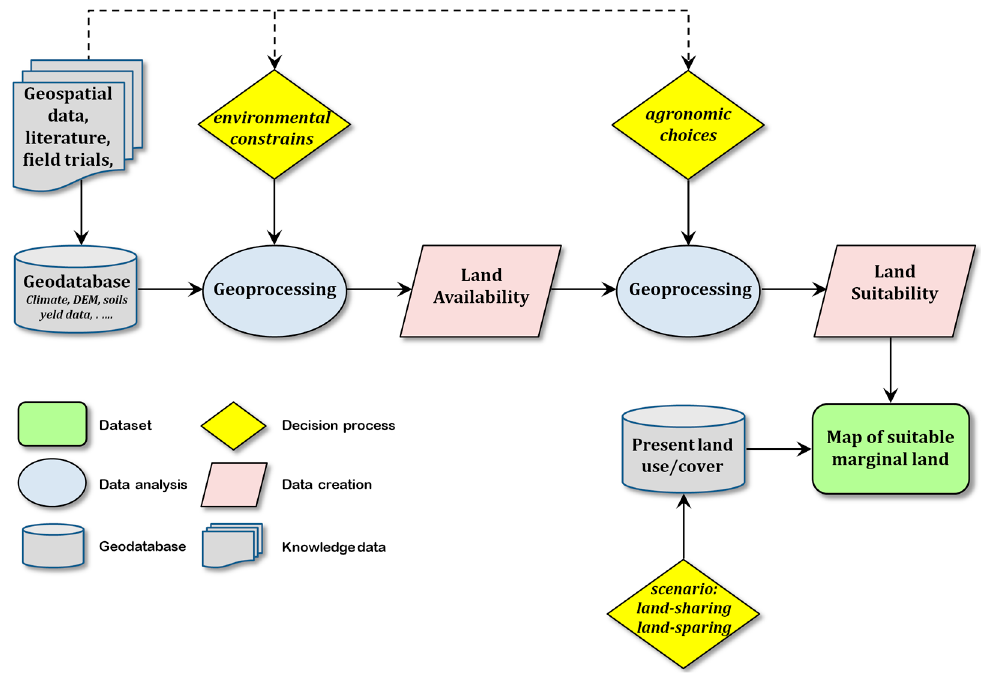
Figure 2. Flowchart illustrating the methodology developed to estimate the land suitability for bioenergy crops.